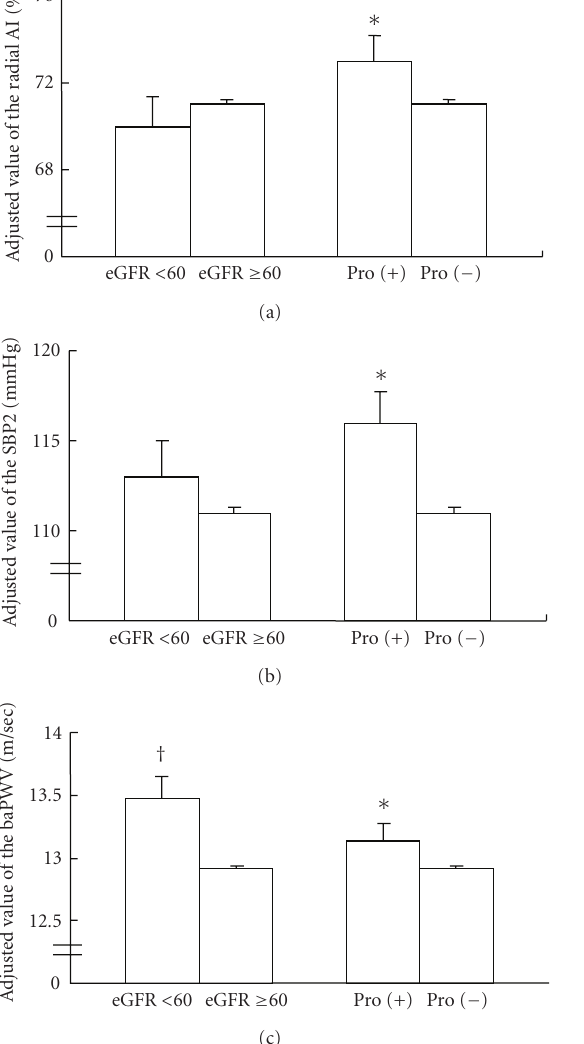
Table 1: Clinical characteristics of the entire study